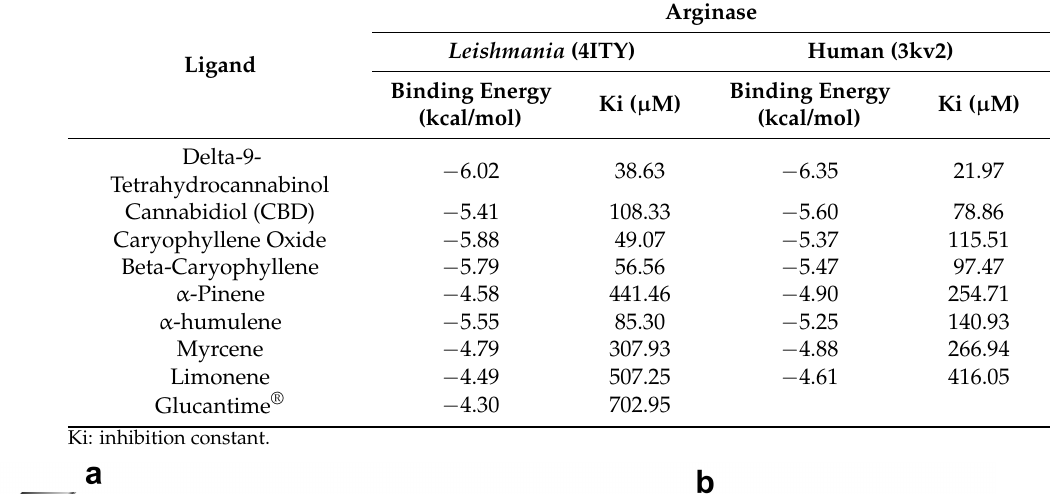
Table 2. Predicted values of binding energies and inhibition constants linking the ligands and the target proteins.